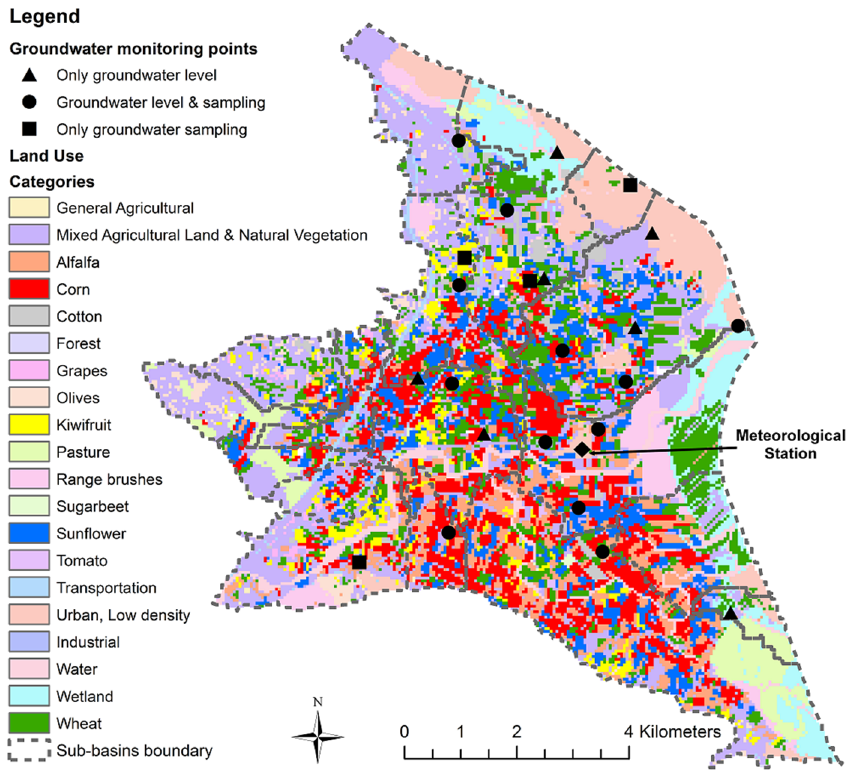
Figure 2. Land use map of PRDP. Groundwater monitoring network and SWAT model sub-basins are also illustrated.